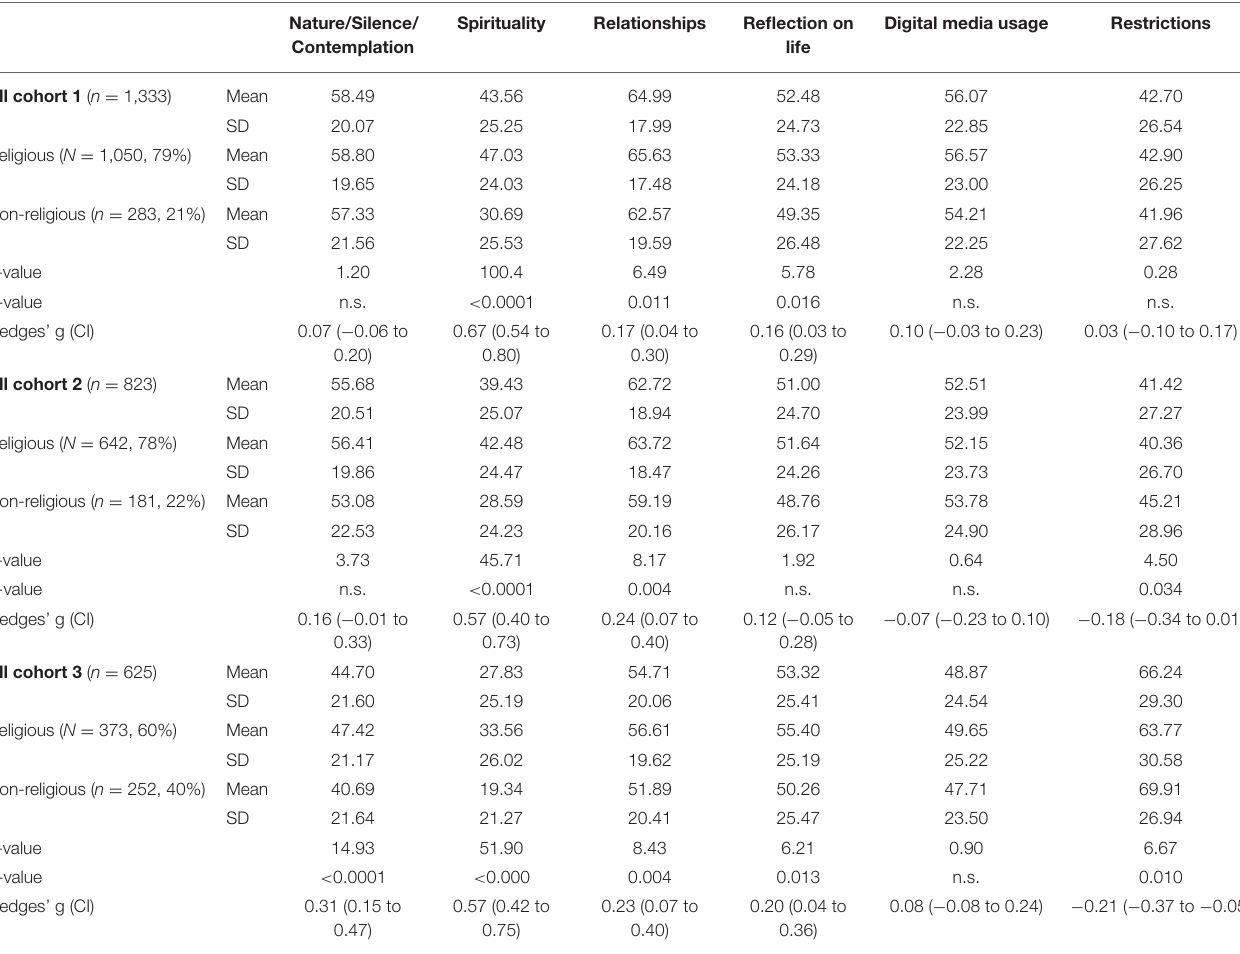
TABLE 3 | Perceived changes in religious and non-religious persons differentiated within the three